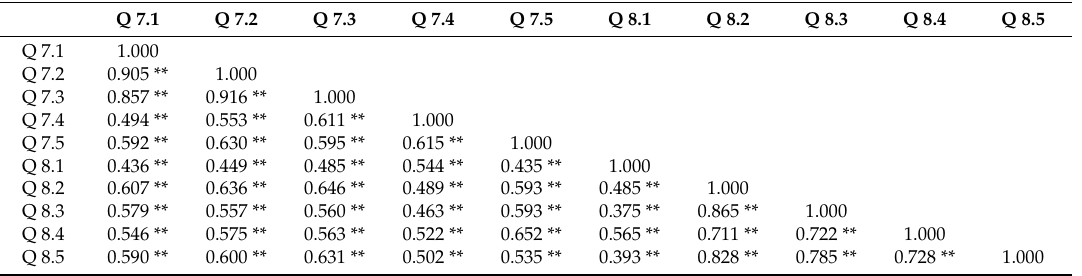
Table 3. Correlation coefficients between questions referring to outcomes of